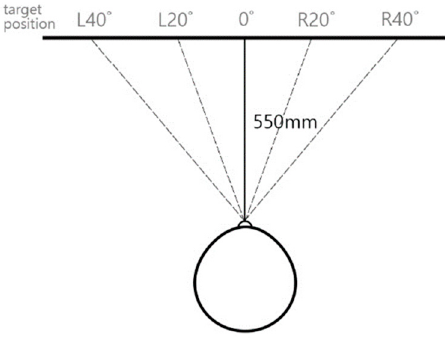
Figure 12. Experiment environment.